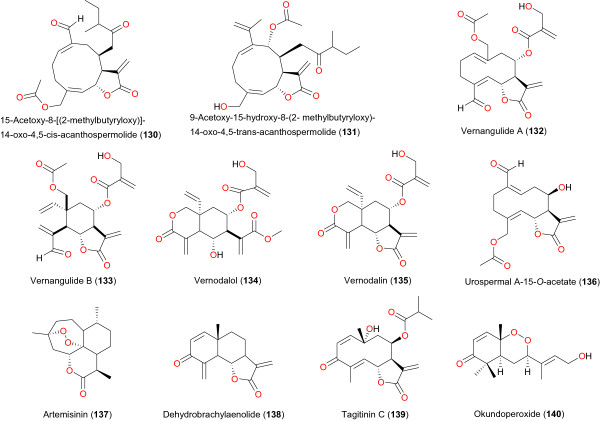
Some anti-malarial sesquiterpenes and sesquiterpene lactones from African medicinal plants - II.